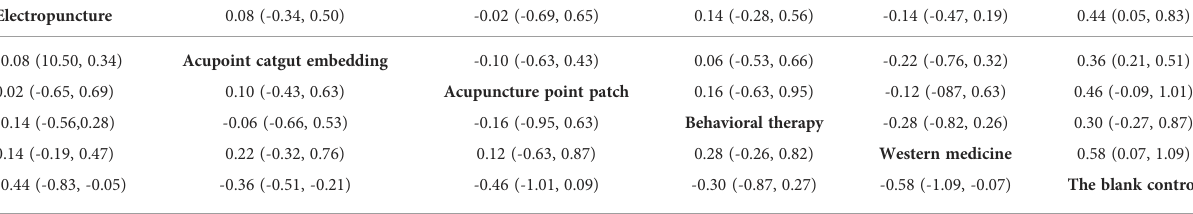
TABLE 2 Network meta-analysis netleague table of fasting blood glucose. Electropuncture